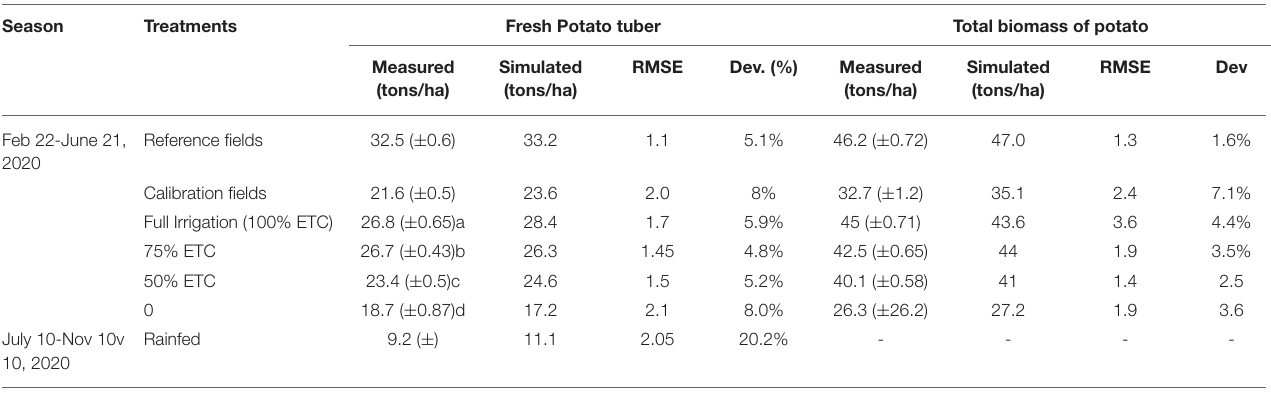
TABLE 4 | Simulated and measured values of potato tuber yield and total biomass from experimental plots during Feb 22–June, 2020 and July 10–Nov 10, 2020 at Barneb 2 irrigation Scheme in northeastern Ethiopia. Season Treatments Fresh Potato tuber Total biomass of potato Measured Simulated RMSE Dev. (%) Measured Simulated RMSE Dev (tons/ha) (tons/ha) (tons/ha) (tons/ha) Reference